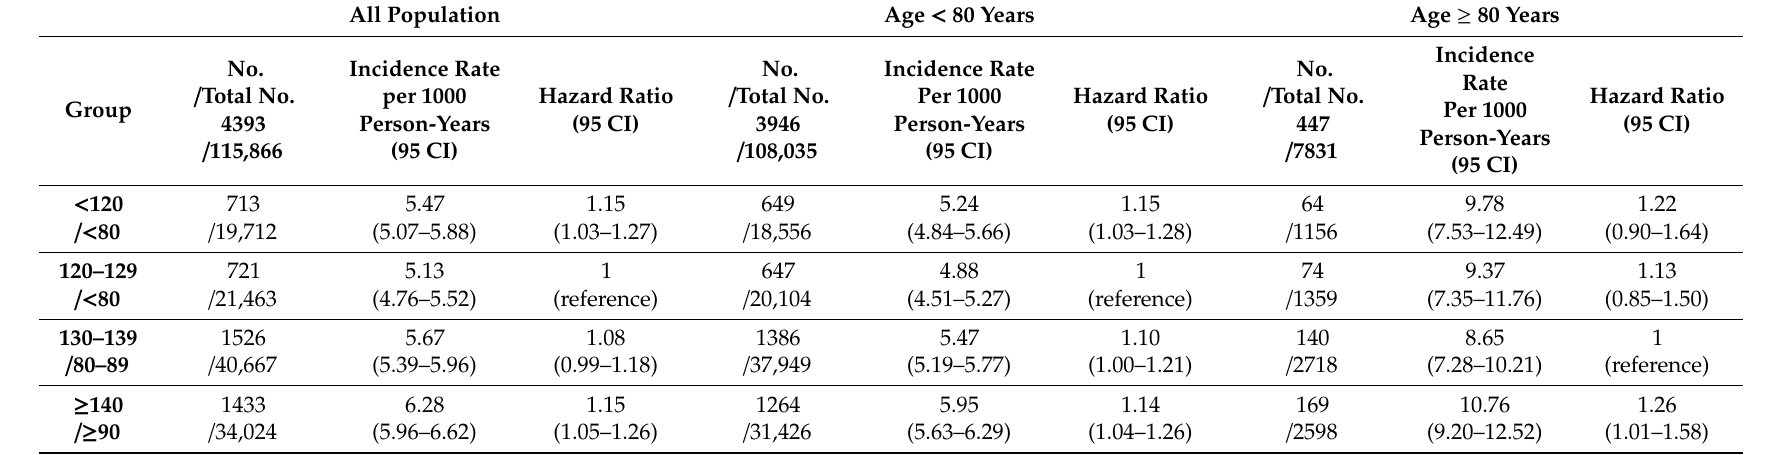
Table 2. Incidence Rate of Atrial Fibrillation According to Blood